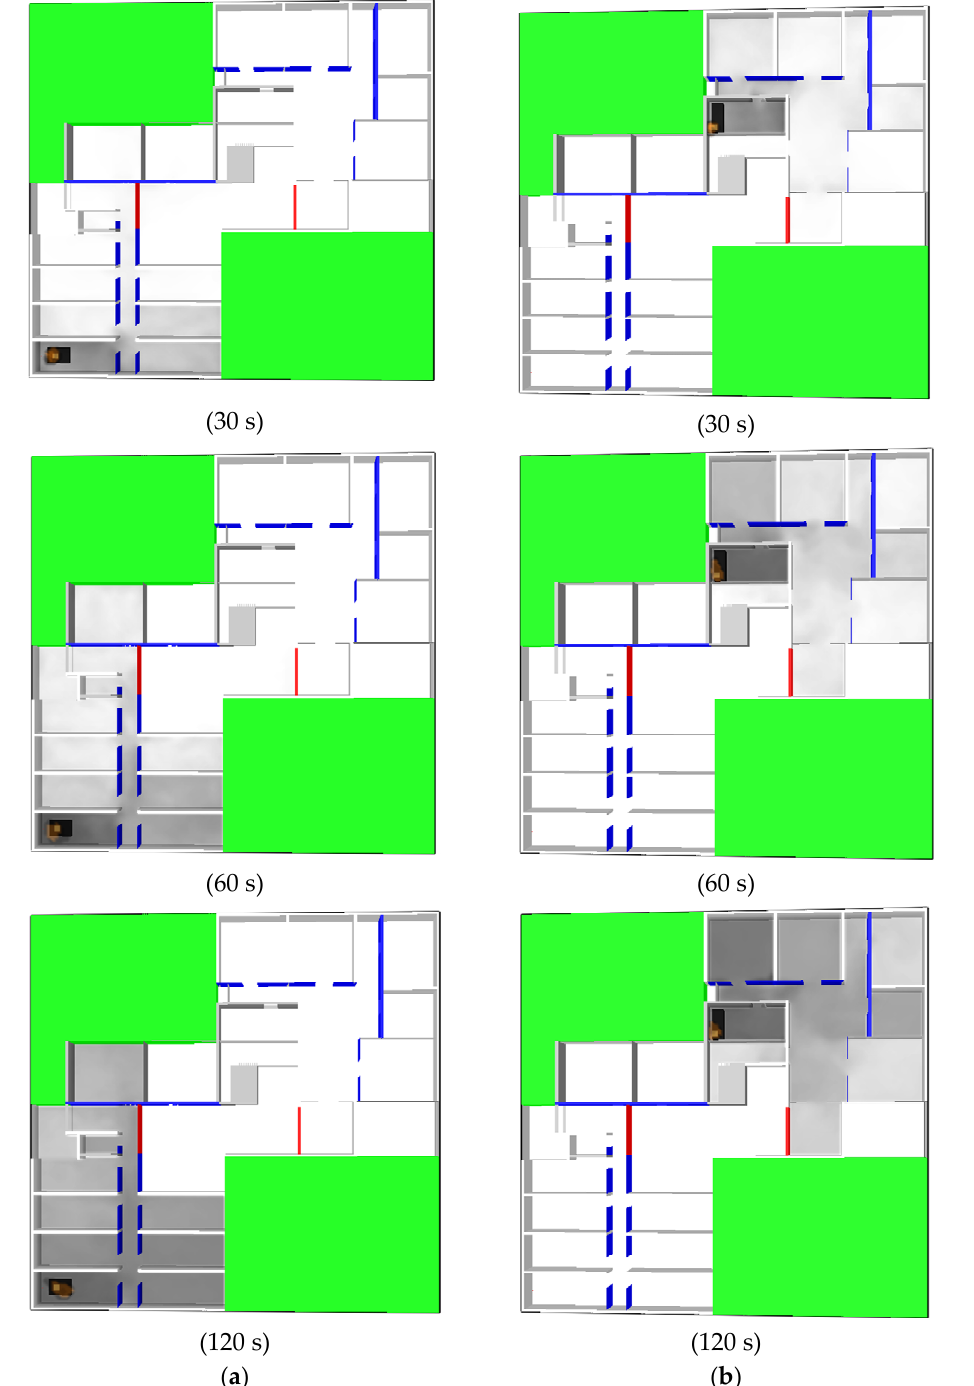
Figure 15. Smoke spread simulation for a temporary evacuation relay station built with a fireproof curtain with the 1.5-h fire-resistance period: ( a ) fire point above a bedside, and ( b ) fire point in the kitchen.